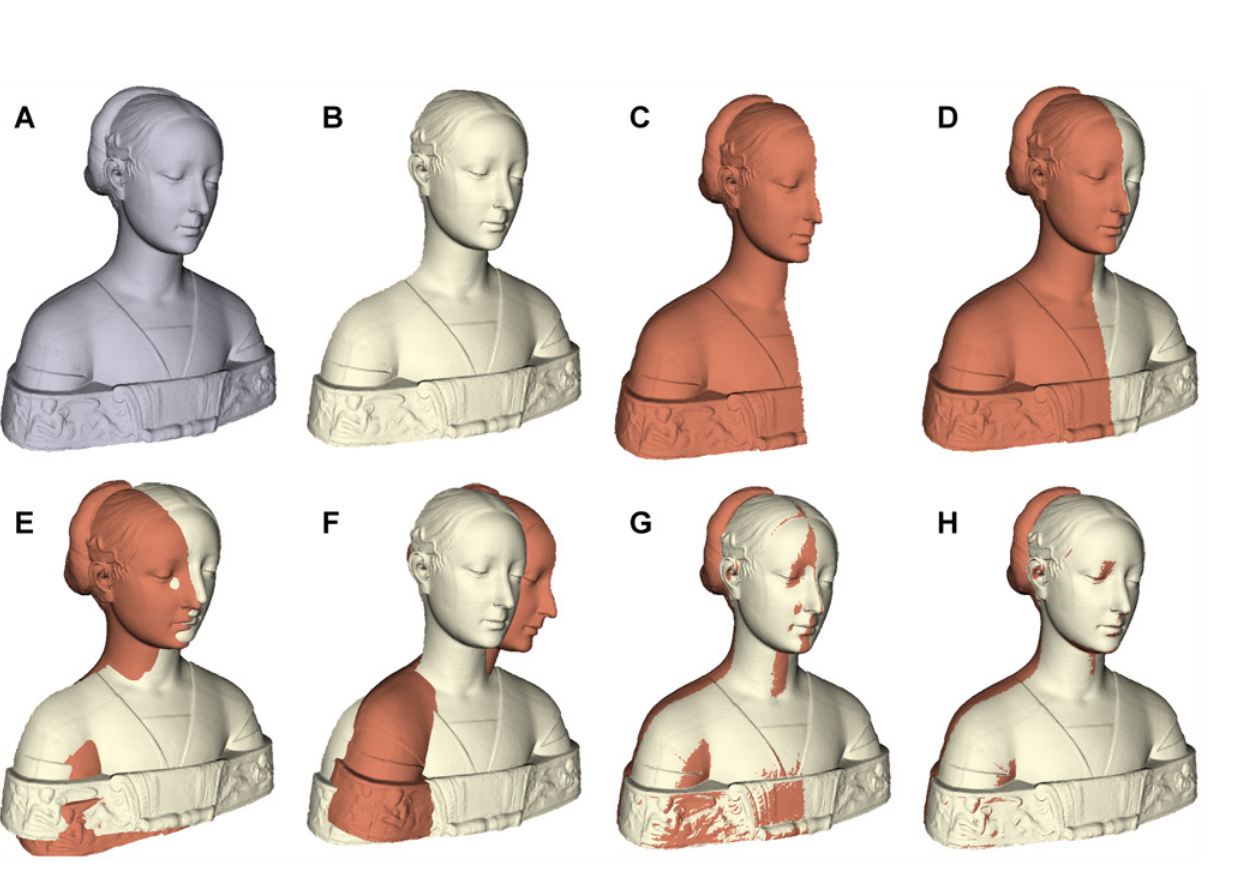
Fig 9. Registration of shapes having partial overlap. (Experiment 7). (A): The statue Laurana sub-divided into (B): front and (C): right half-sections, such that (D): a 50% overlap exists between the two sub-shapes. The sub-shapes were (E): misaligned by 10 mm and 10 degrees in a random direction and then registered using (F): CPD [20], (G): GICP [11], and (H): the proposed IMLP algorithm. Sub-figures (E-H) show the initial misalignment and the final registered alignments of the two shapes for the 6th randomized trial of Experiment 7, which involved 10 randomized trials in